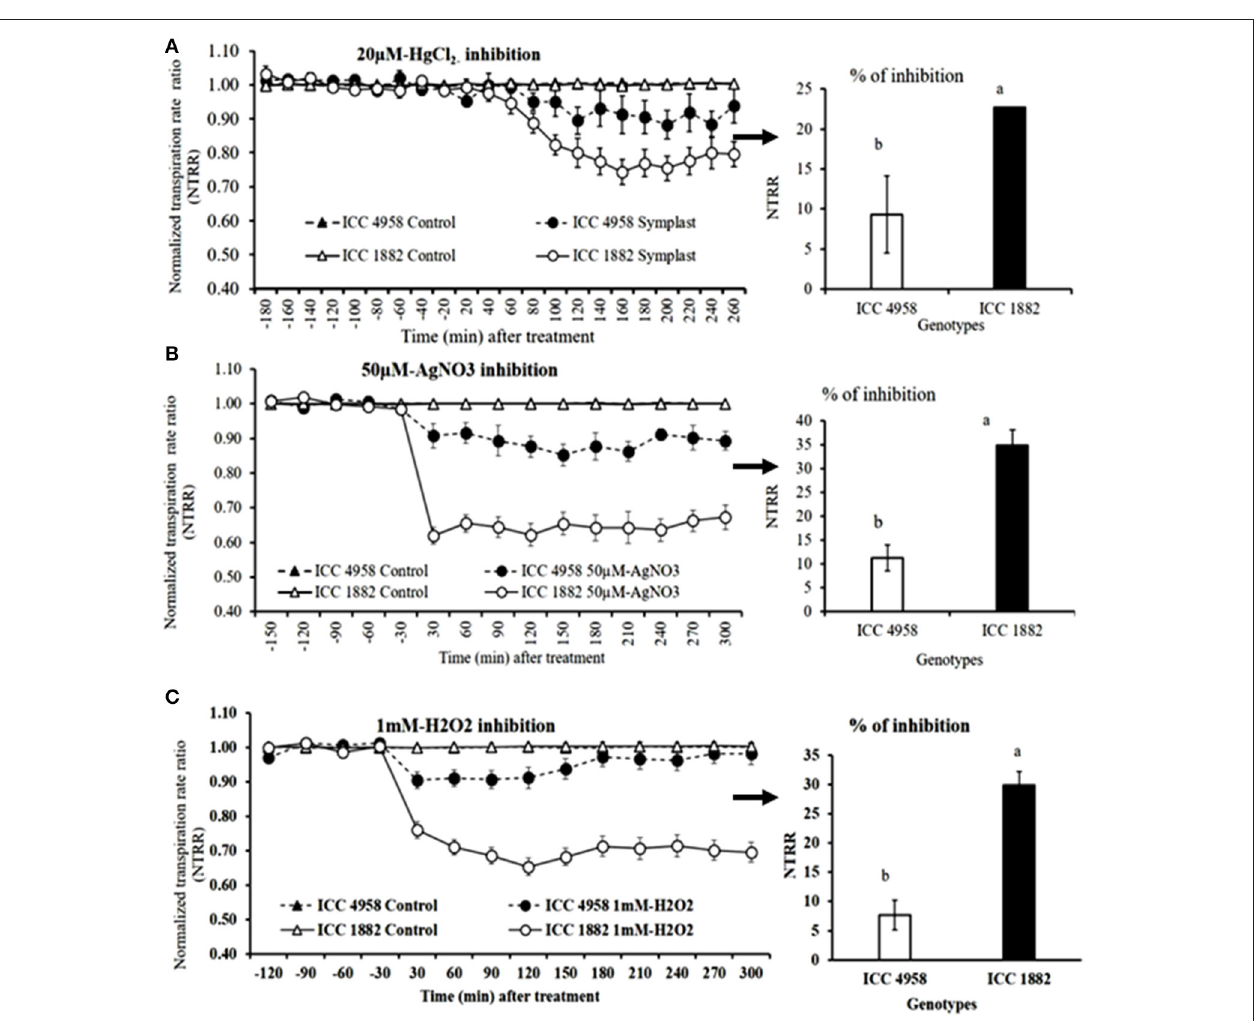
FIGURE 3 | Decline in transpiration rate of two chickpea genotypes contrasting for plant vigor to the aquaporin inhibitors; 20 µ M-HgCl 2 , 50 µ M-AgNO 3 , and 1 mM-H 2 O 2 . The dashed lines with round shaped closed symbols represent ICC 4958 and the solid line with round shaped open symbols represent ICC 1882 genotype. The graph (A) represents the inhibition with 20 µ M-HgCl 2 and graph (B) represents the inhibition with 50 µ M-AgNO 3 . The graph (C) represents the inhibition with 1 mM-H 2 O 2 . The arrows with respective bar graph represents % of inhibition, open bar represents, ICC 4958 and closed bar represents ICC 1882. Bars with different letters are significantly different ( P < 0.05). Each treatment’s data points represent the NTRR means ( ± SE) of eight replicates per genotype.